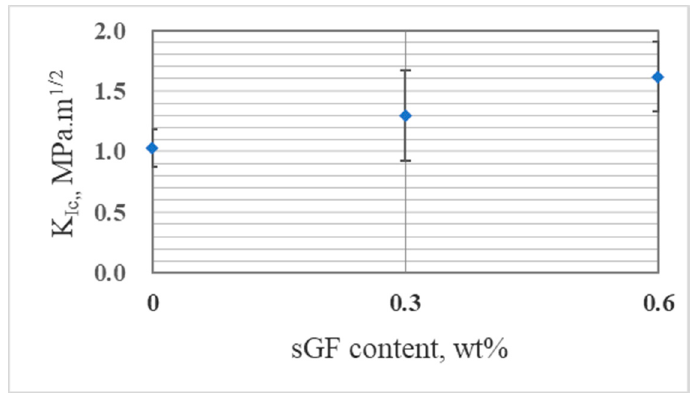
Figure 8. The improvement of fracture toughness of resin with the addition of sGF [25].